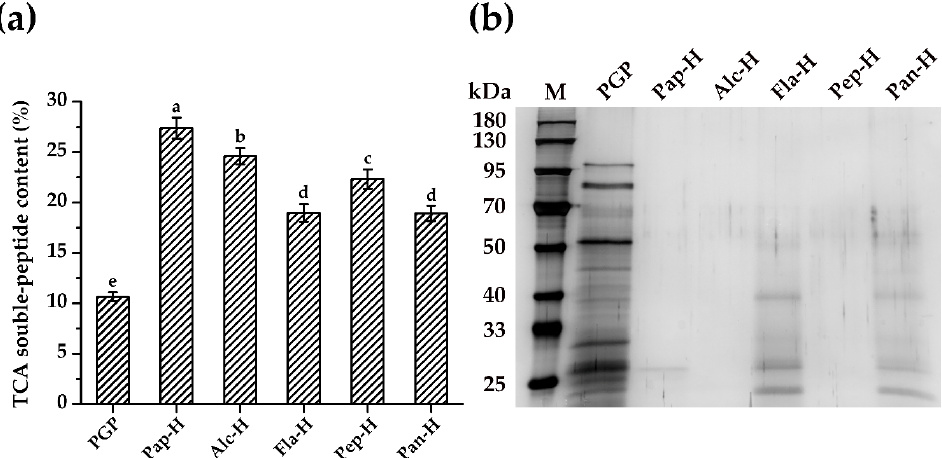
Figure 1. The efficiency of different enzymes in hydrolyzing Pleurotus geesteranus protein (PGP). ( a ) TCA-soluble peptide content in PGP and its hydrolysates; Data are expressed as mean ± SD ( n = 3). Bars with different alphabets indicate statistically significant difference between the means ( p < 0.05). ( b ) Sodium dodecyl sulfate-polyacrylamide gel electrophoresis (SDS-PAGE) profile of PGP and its hydrolysates generated by various enzymes; 20 µ g of protein were loaded into the corresponding